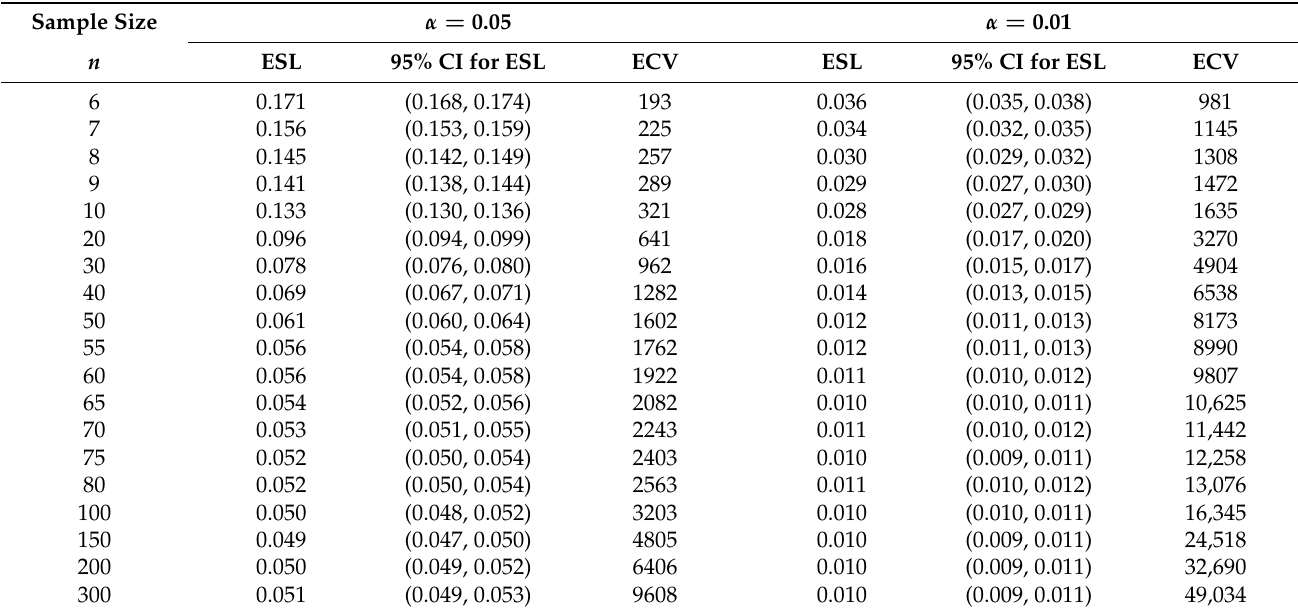
Table 2. ESLs with asymptotic 95% CIs of the supremum test statistic for various sample sizes when d = 5 and the NSLs are equal to 0.05 or 0.01.